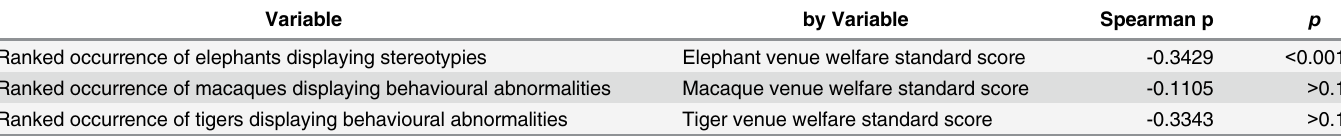
Table 1. Spearman ’ s Correlation Coefficient and P-value for correlations between ranked occurrence of animals displaying stereotypies and the venues ’ welfare standard score. For elephant venues a significant negative correlation can be seen, while for macaque and tiger venues the data did not produce significant enough results.